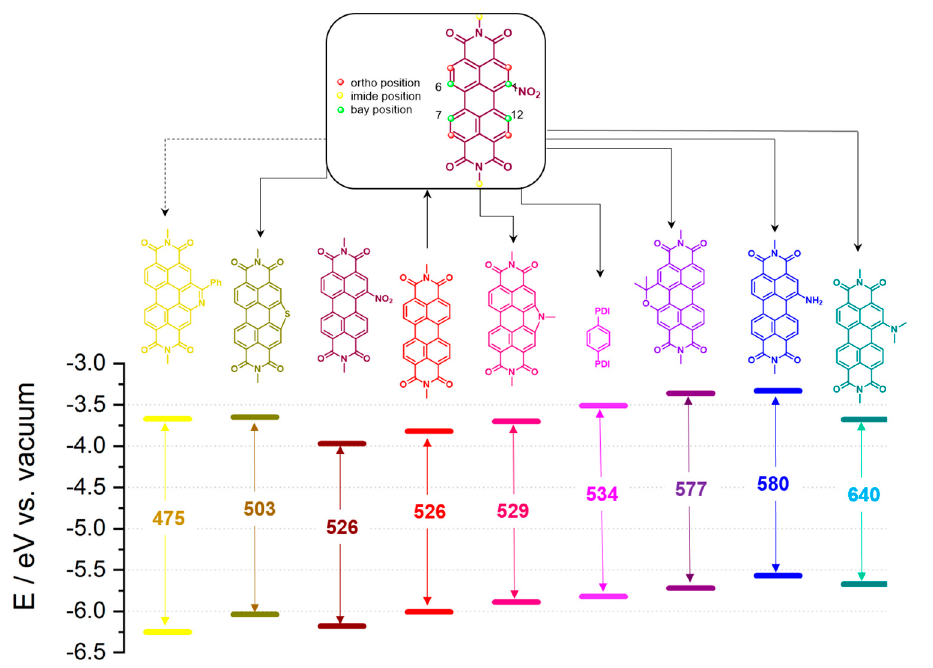
Figure 1. 1-NitroPDI, a key intermediate for reaching various bay-substituted-PDI structures with distinct photoredox properties. Frontier orbital energy (HOMO-LUMO) levels of PDIs. Wavelengths (nm) of maximal absorption of light are shown. The data were collected from references [30–35].